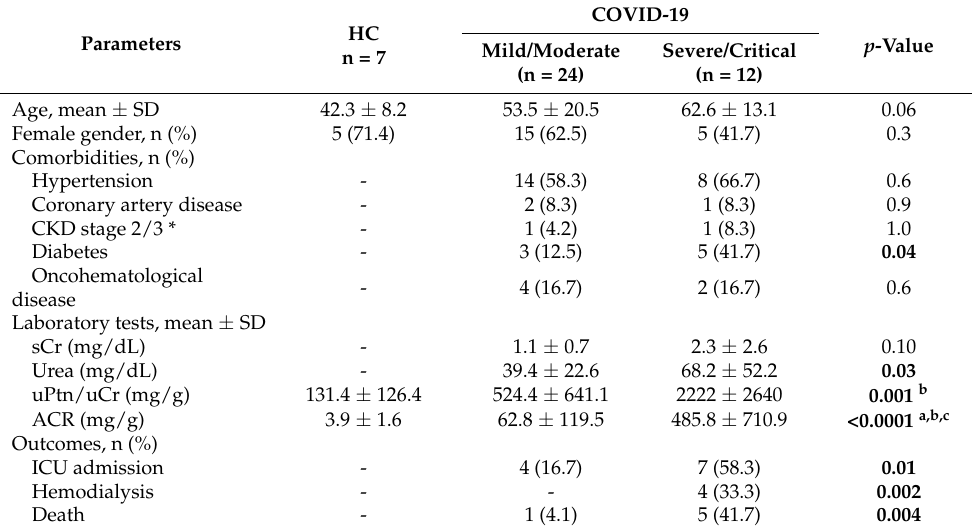
Table 1. Demographic and clinical characteristics of COVID-19 hospitalized patients and healthy